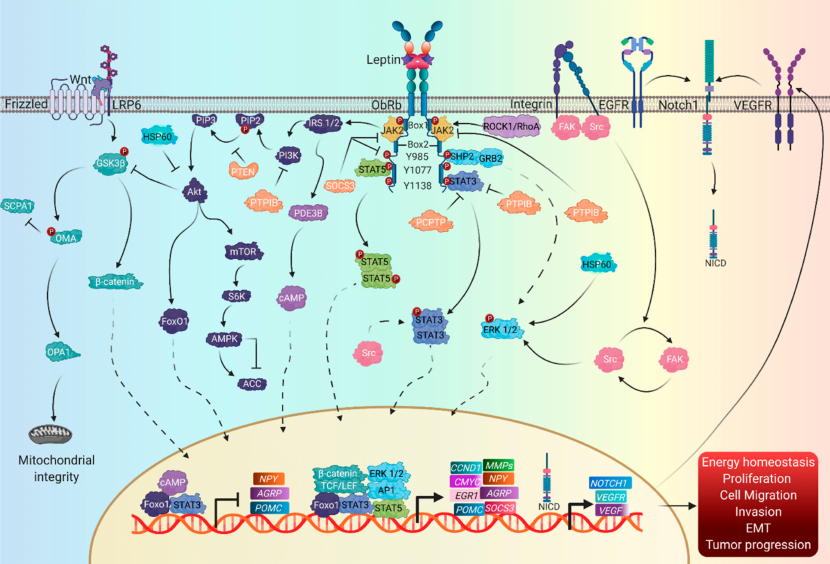
Figure 2. Leptin-induced signaling pathways. The leptin signaling pathway is initiated by leptin–ObR-b receptor interaction, recruitment of ROCK1 (Rho associated coiled-coil containing protein kinase 1), and subsequent activation of JAK2 (Janus kinase 2), which phosphorylates downstream Tyr985, Tyr1077, and Tyr1138 residues. Three canonical signaling pathways that trigger leptin have been reported and are related to the regulation of food intake and energy expenditure. The JAK2-STAT3-5 (signal transducer and activator of transcription 3–5) pathways are the major leptin pathways and induce the expression of appetite–regulating genes and SOCS3 (suppressor of cytokine signaling 3). The MAPK / ERK1 / 2 pathway is related to the expression of early response genes involved in cell proliferation and di ff erentiation. The IRS1-2-PI3K-Akt pathway is initiated by the direct recruitment of IRS (insulin receptor substrate) to JAK2, triggering the activation of proteins related to the expression of weight-regulating neuropeptides. Inhibition of leptin signaling is mediated by SOCS3 through a negative feedback loop, although PTP1B (protein tyrosine phosphatase 1B) proteins have also been